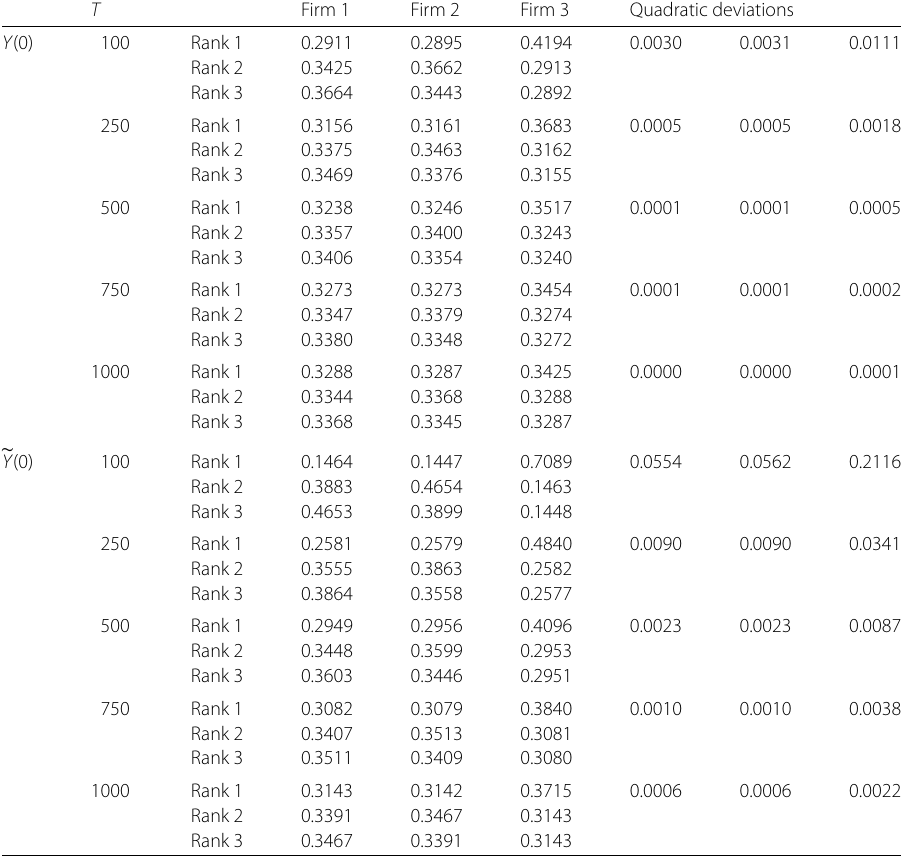
Table 7 Discrete occupation rates for the discretized Atlas